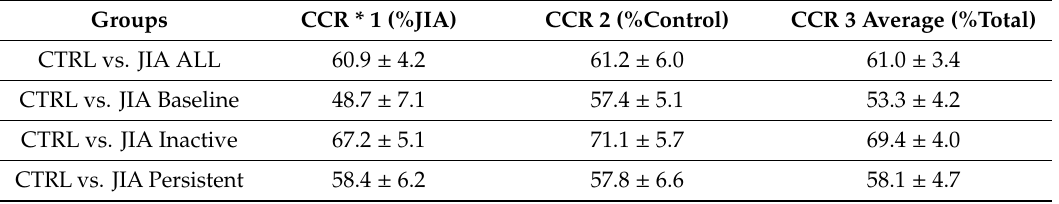
Table 4. PLS-DA models in DCV of operational taxonomic units (OTUs) at family level.